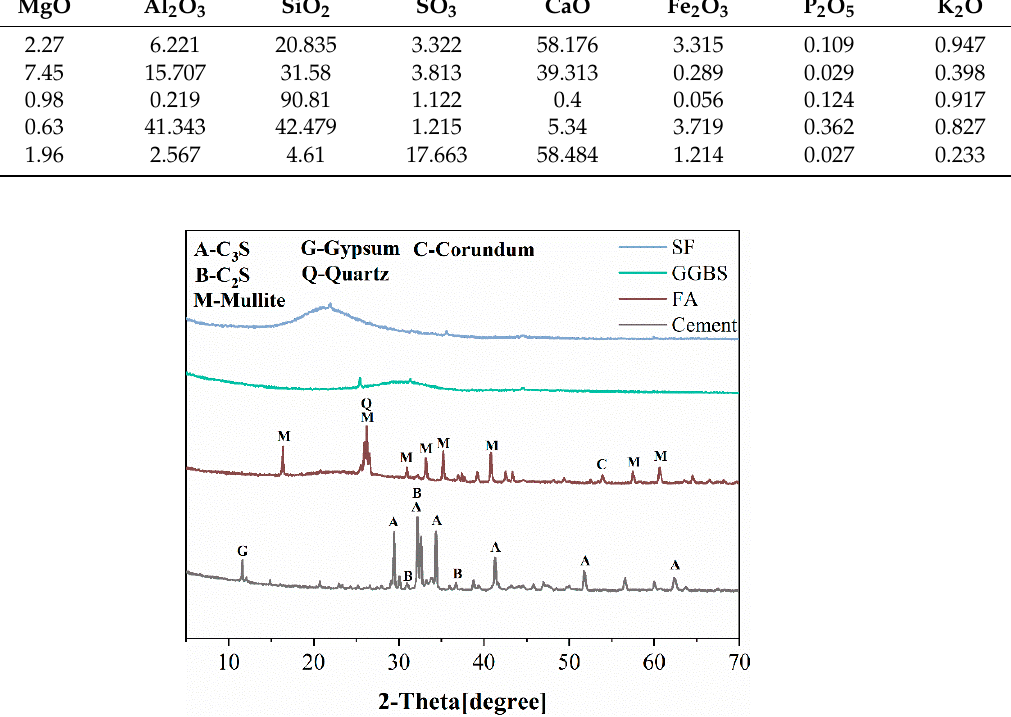
Table 2. Proportions of concrete mix (kg/m 3 ).